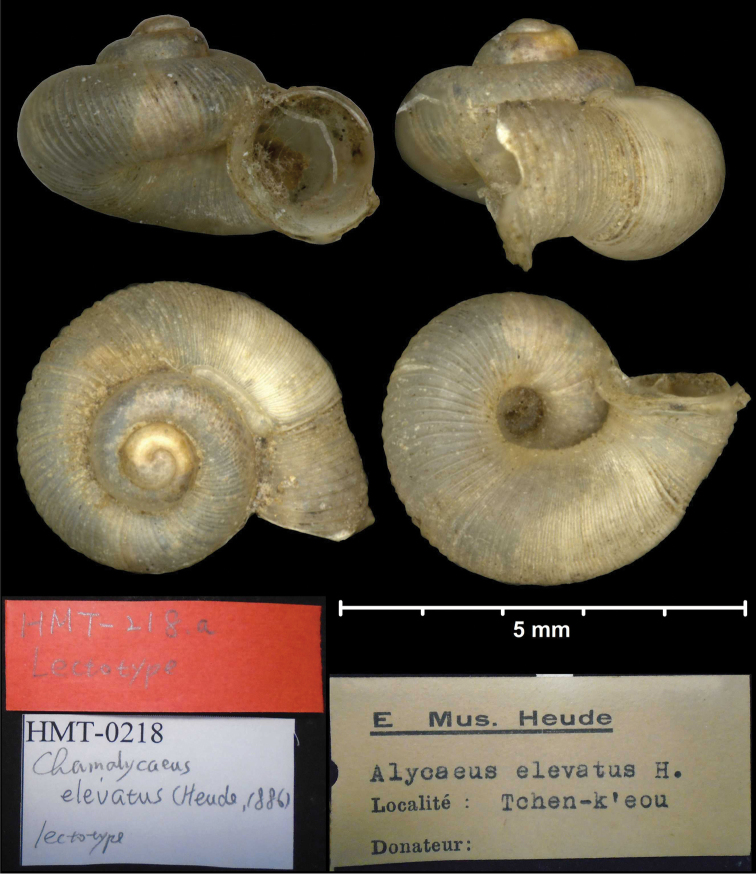
Dicharax
(?)
elevatus (Heude, 1886), syntype (HMT-218a). Photographs: Kaibaryer Meng.